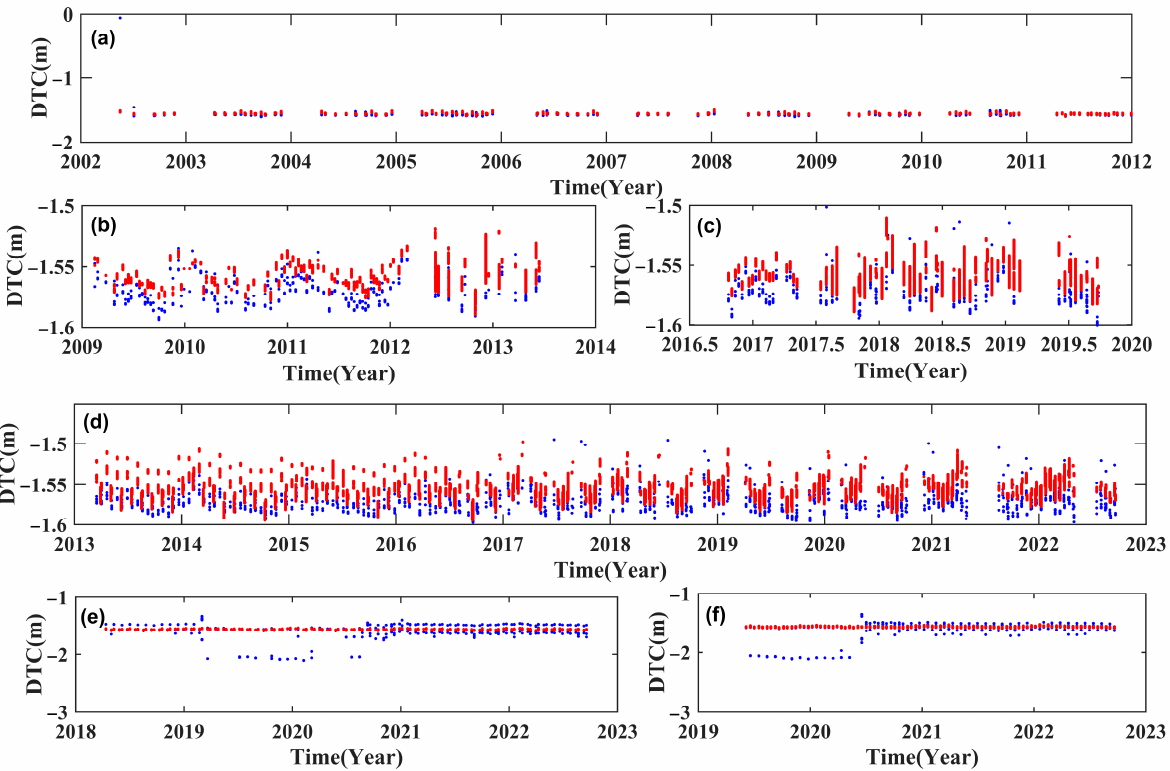
Figure 3. A comparison of the reprocessed DTC and products values. ( a – f ) The Envisat RA-2, Jason-1, Jason-2, SARAL, Sentinel-3A SRAL, and Sentinel-3B SRAL satellites, respectively, until September 2022. Red represents the reprocessed data, and blue represents the values of the products.